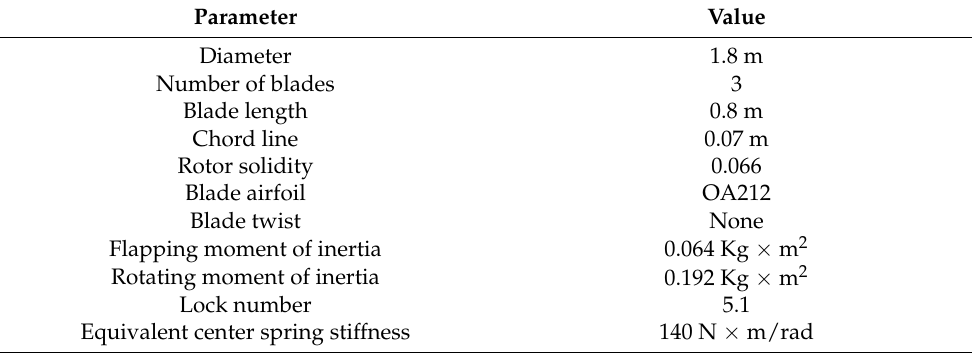
Table 1. Rotor Model